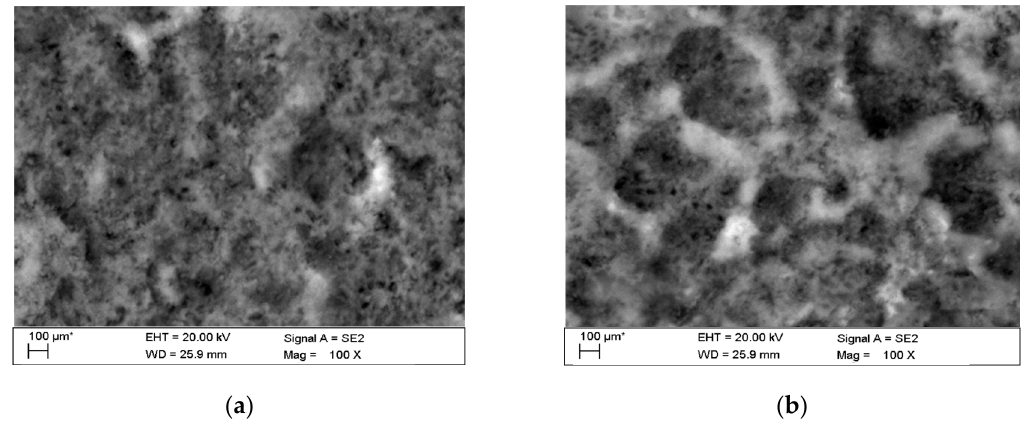
Figure 17. Interior of pits created during corrosion tests: ( a ) in tap water, ( b ) in demineralised water.